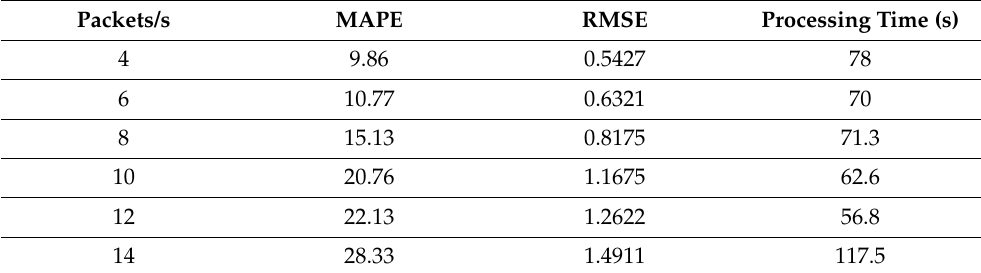
Table 2. Comparison of prediction accuracy for V2X traffic using RMSE and